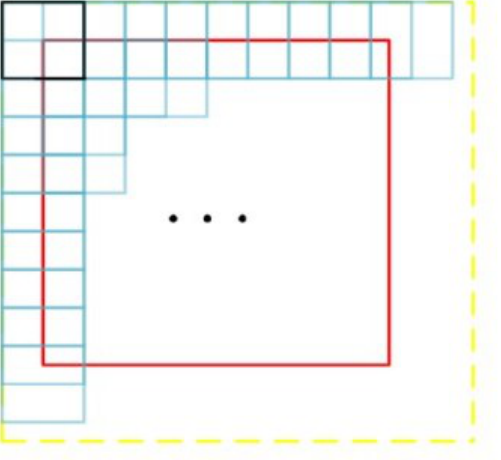
Figure 4. Diagram of filling and cropping with test sets overlap